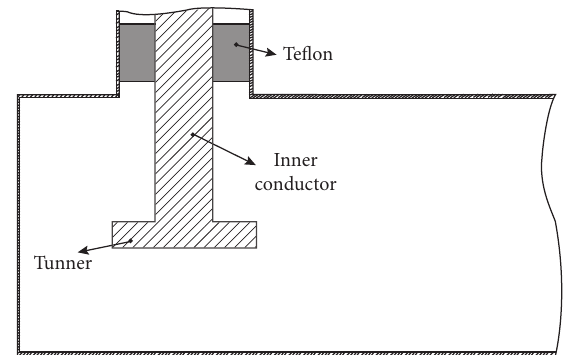
Figure 1: Schematic diagram of rectangular-to-coaxial coupling